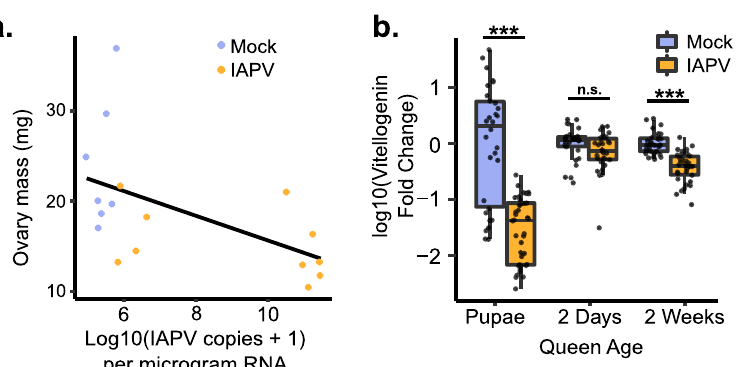
Figure 2. Relationships between viral RNA copies and ovary mass. See Table 2 for complete statistical details. ( a ) Survey 1 (previously published; see Table 1 for details) included viral RNA copies for deformed-wing virus A (DWV-A), sacbrood virus (SBV), and black queen cell virus (BQCV), using head tissue samples. ( b ) Viral RNA copies for each virus were added to produce the variable “Total viral load” and analyzed as a fixed effect instead of individual virus copies. ( c ) Proportion of each virus in each queen, ordered by increasing ovary mass. ( d - f ) The same relationships from a validation data set (Survey 3) of n = 54 queens analyzed for 8 different viruses in the thorax using a different laboratory service. Queens were mainly infected with DWV-B (non-detected viruses not shown), with sporadic DWV-A and Lake Sinai virus (LSV). For ( a ) and ( d ) data were analyzed using a linear mixed effect model with queen source as a random effect, and the copies of each virus and health status (healthy vs. failing) as fixed effects. Regression lines shown only for viruses with > 1 non-zero point. ( e ) The summed total viral load was analyzed as a fixed effect instead of the individual virus copies.